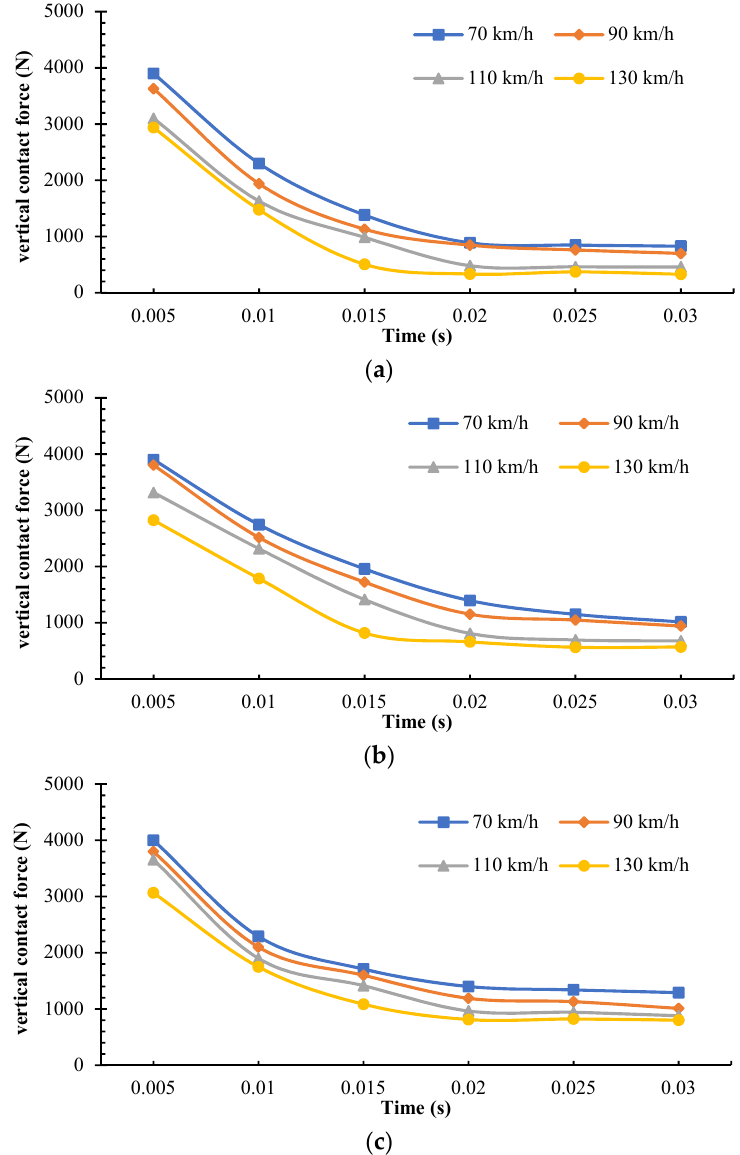
Figure 20. Effects of tire rolling velocity on vertical contact force. ( a ) AC pavement; ( b ) SMA pavement; ( c ) OGFC